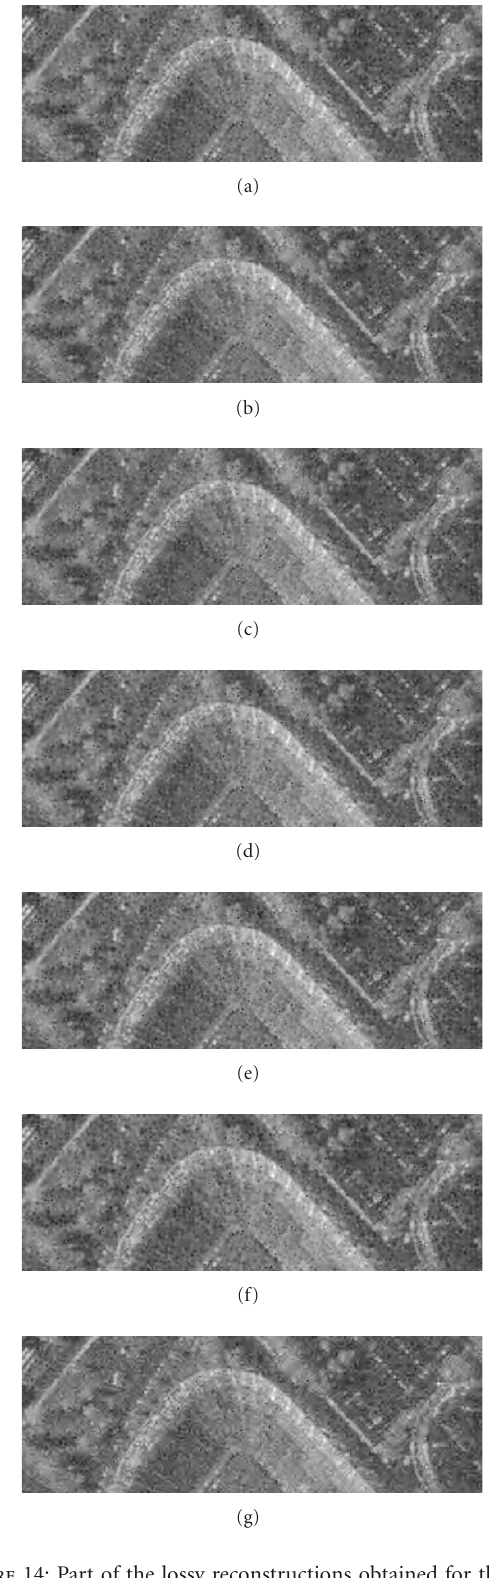
Figure 14: Part of the lossy reconstructions obtained for the sar2 image at a compression ratio of 32 using the (a) OPT1, (b)